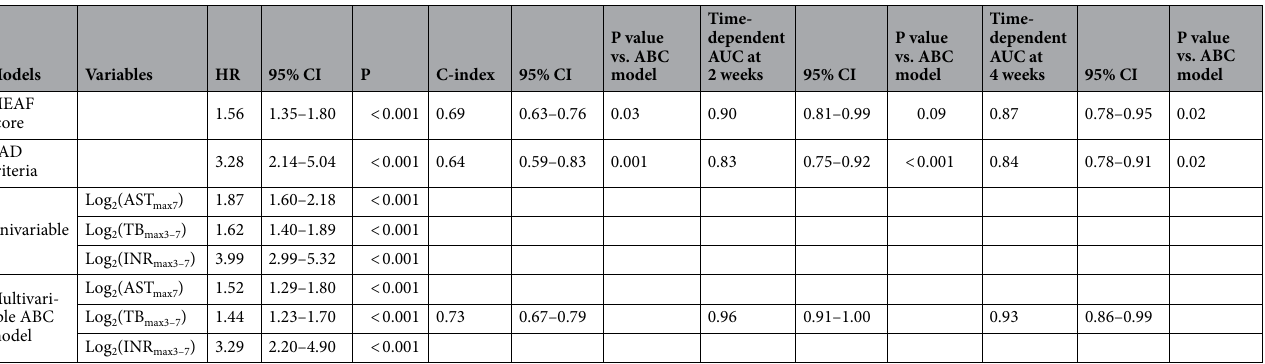
Table 2. Comparisons of C-index, time-dependent AUC at 2 weeks, and time-dependent AUC at 4 weeks between Cox proportional hazard regression models using MEAF score, EAD criteria and newly developed multivariable model for predicting graft survival of recipients who underwent living donor liver transplantation. HR hazard ratio, AUC area under the curve, CI confidence interval, MEAF modeling early allograft function, EAD early allograft dysfunction, AST aspartate aminotransferase, TB total bilirubin, INR international normalized